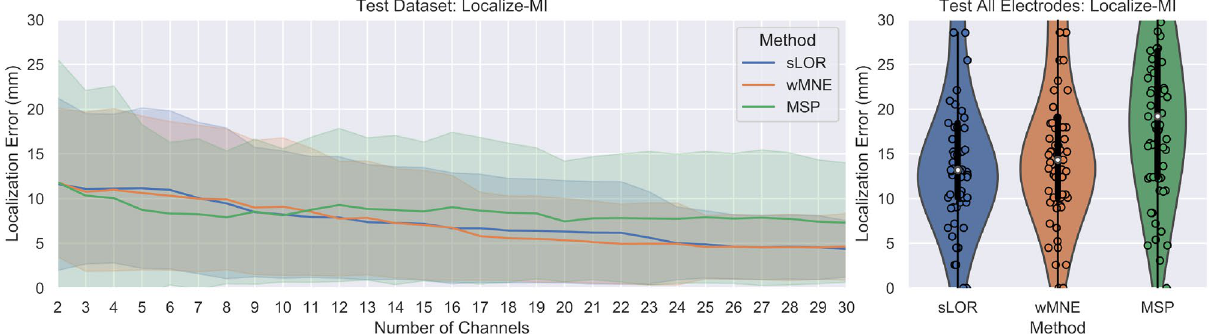
Figure 11. Results for the Localize-MI test. The pseudo-Pareto fronts relating to the number of channels and the localization error by each source reconstruction method are presented at left. The lines represent the mean localization error across the 61 sessions and their respective colored bands represent their standard deviation. The mean localization errors across the trials and the standard deviation obtained by using all the electrodes available (all channels labeled as good) by each method are presented at right.